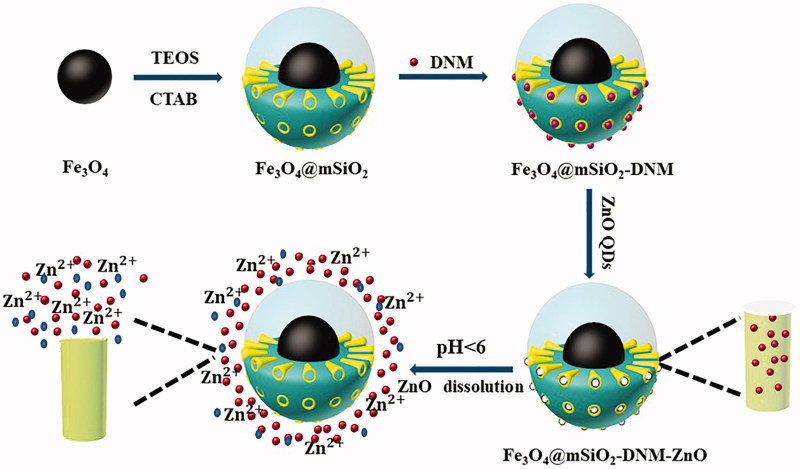
Schematic illustration for the construction of Fe3O4@mSiO2-DNM-ZnO NPs and the controlled release process.